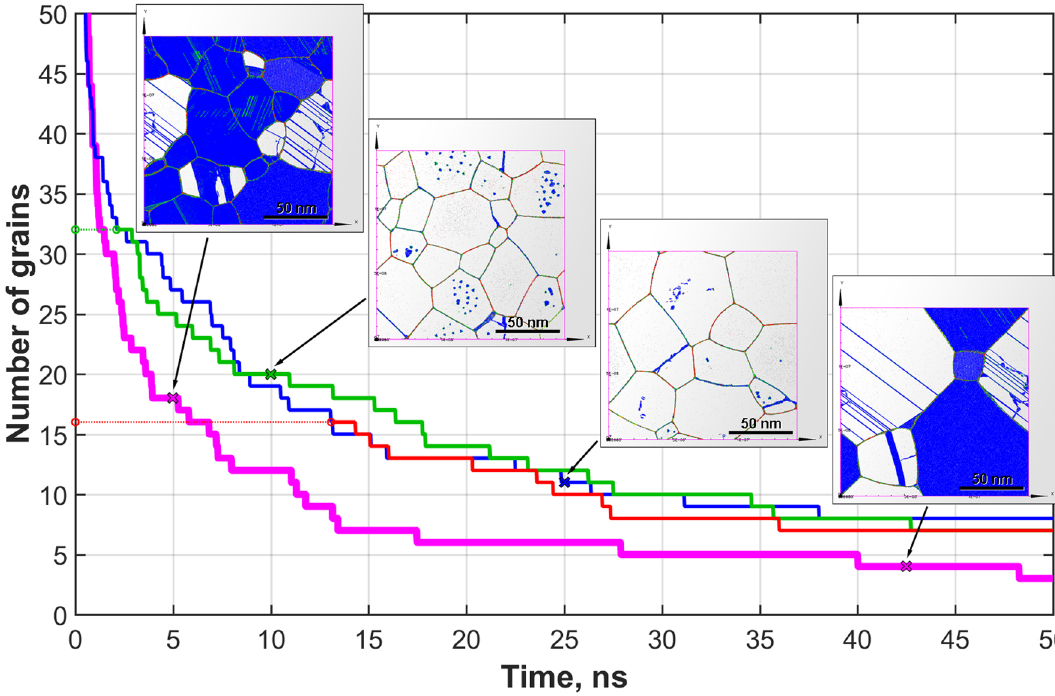
Figure 4. Grain coarsening upon annealing (number of grains in samples vs. time). The insets show the grain structures at different times. The thin solid lines are for samples of V-type with different initial numbers of grains: the blue, green, and red lines are for the V1, V2, and V3 samples (64, 32, and 16 initial grains, respectively). The last two lines are shifted to the times when the initial numbers of grains are equal to the current ones on the blue line for the V1 sample. The thick solid magenta line is for the sample of